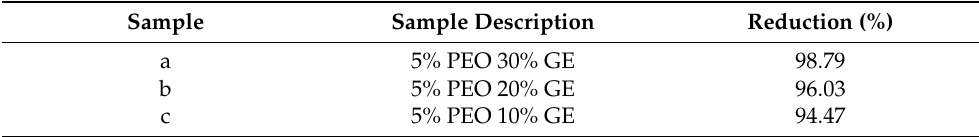
Table 4. Bacterial reduction of the PEO/GE